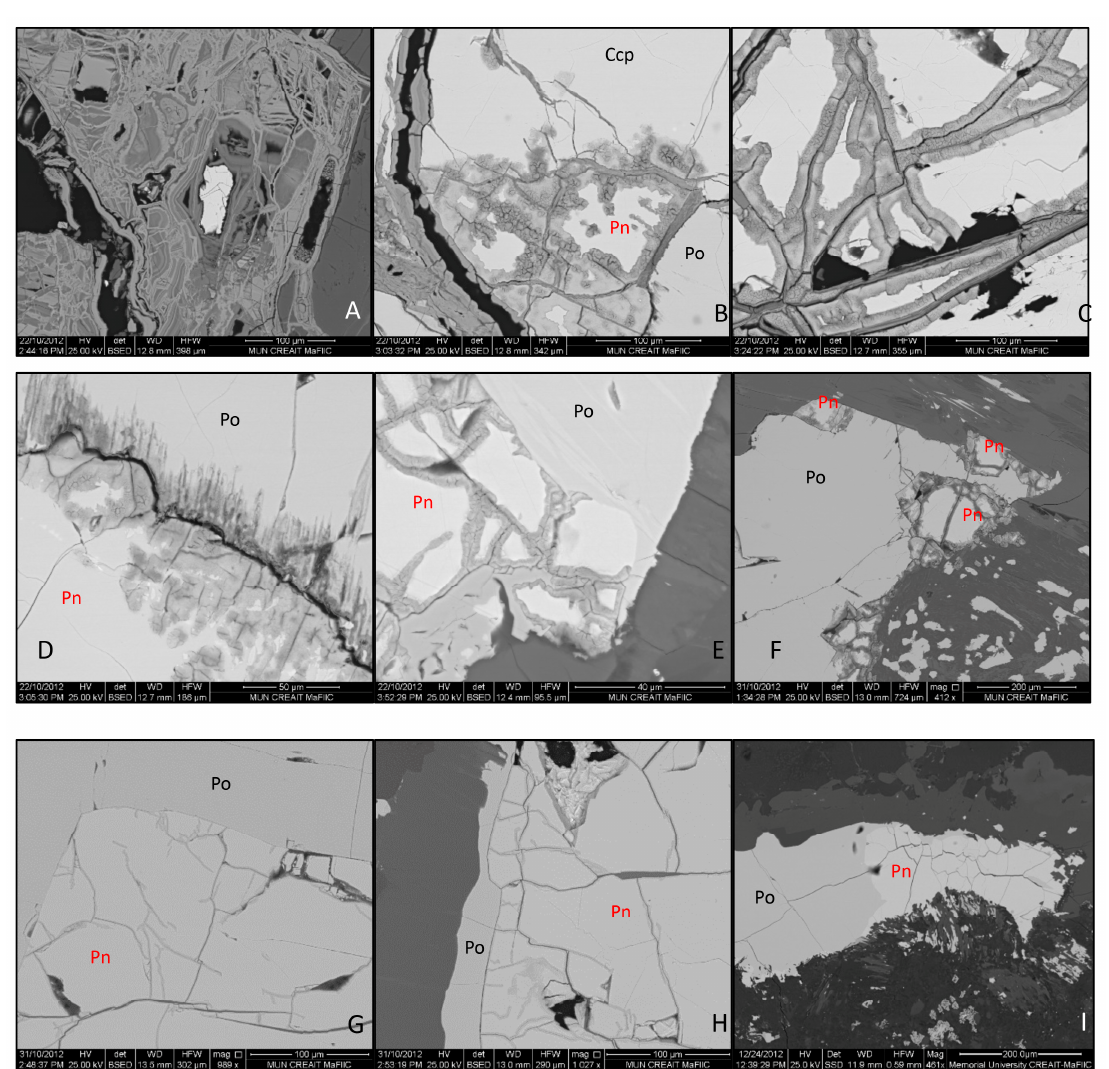
Figure 3. BSE images of polished thin sections from Voisey’s Bay drill hole VB95-139: ( A ) Chalcopyrite grain (bright) surrounded by completely oxidized massive sulphide (3.4–3.48 m), ( B ) chalcopyrite (Ccp) and pyrrhotite (Po) in contact with highly altered pentlandite (Pn) containing remnant “islands” of Pn (bright grey) (3.9–3.97 m), ( C ) highly oxidized Pn with alteration spreading out from internal fractures (3.9–3.97 m), ( D ) highly oxidized Pn (lower left) in contact with slightly altered Po (upper right) (3.9–3.97 m), ( E ) Pn (white) oxidized along fractures in contact with unaltered, and twinned Po (upper right) (4.96–4.98 m), ( F ) Po with patches of altered Pn (7.45–7.5 m), ( G ) incipient oxidation of Pn along fractures in contact with unaltered Po (9.35–9.4 m), ( H ) incipient oxidation of Pn along fractures in contact with unaltered